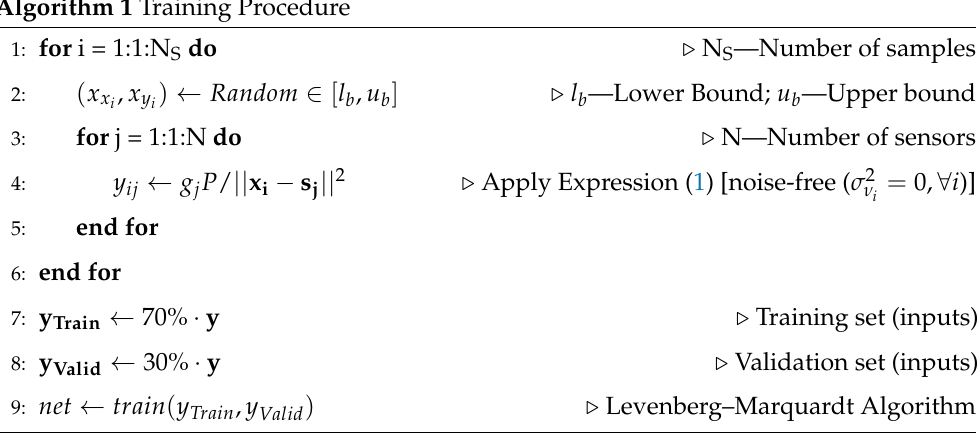
Algorithm 1 Training